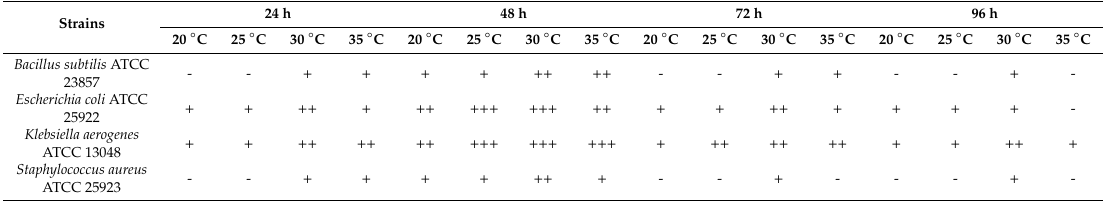
Table 1. The optimum conditions for antibacterial peptides produced from Saccharomyces cerevisiae. Strains 24h 48h 72h